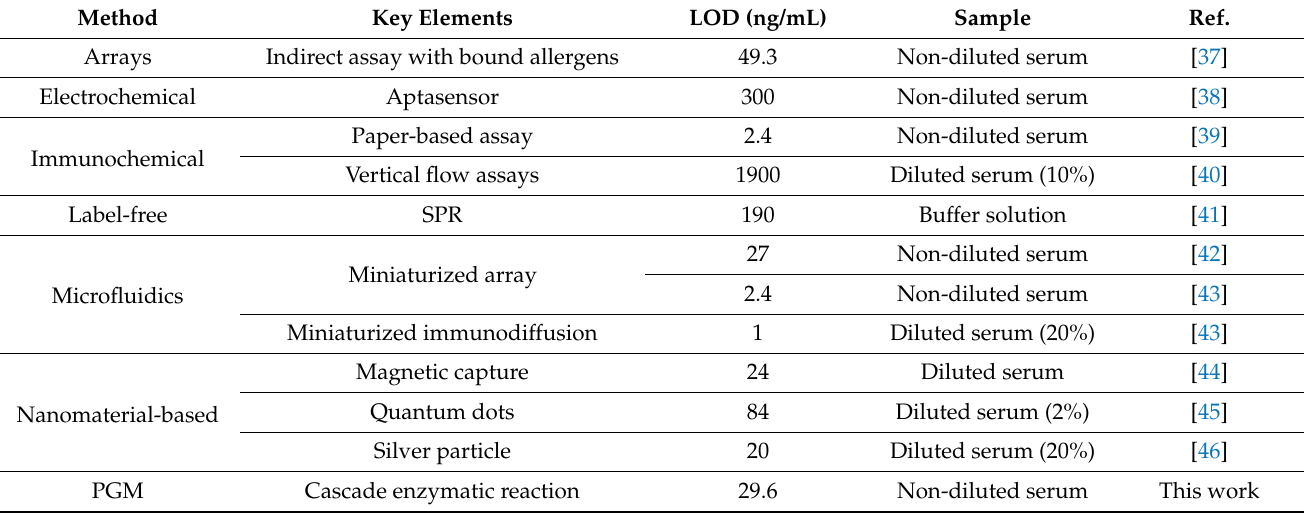
Figure 4. ( a ) The linear relationship between the PGM signal and target IgE concentration within the range of 0 to 400 ng/mL. ( b ) Detection selectivity of the IgE detection system. The concentrations of IgE and other antibodies (IgG, BSA, HSA, and anti-cTnI) were 1 µ g/mL and 10 µ g/mL, respectively. The p -values (unpaired two-tailed t -test) of IgG, BSA, HSA, and anti-cTnI toward IgE were 0.0003, 0.0005, 0.0001, 0.0002, and 0.0001, respectively. p -values lower than 0.05 were considered significant. Table 1. Summary of the previously reported IgE detection methods.